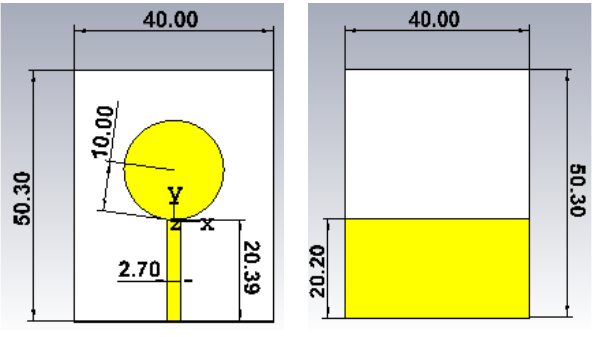
FIGURE 1. Designed UWB-CMSA. All dimensions depicted in the figure are in mm. Fig. 3 represents simulated and measured results for UWB-CMSA which are in close agreement over the entire band i.e., return loss of 10 dB is achieved over the range of